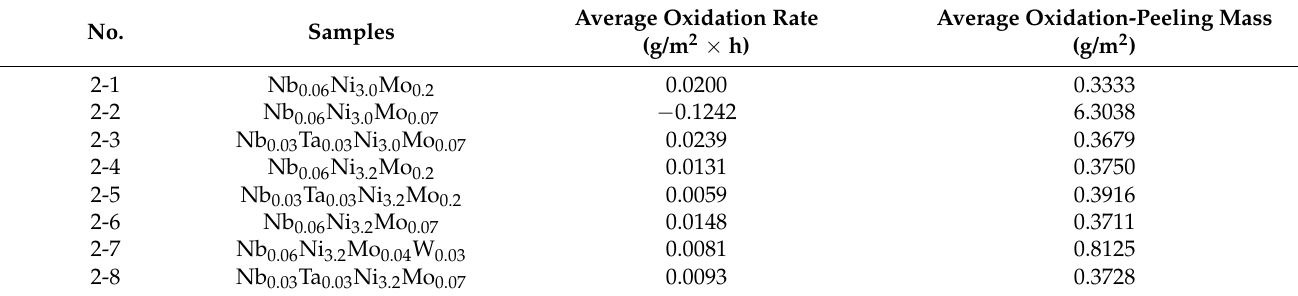
Table 3. The average oxidation rate and oxidation-peeling mass of designed series-2